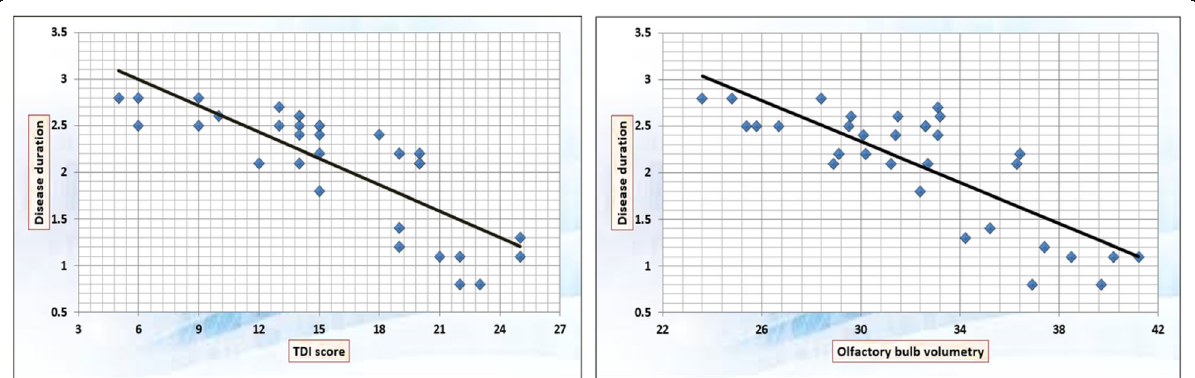
Fig. 3 Negative correlation between Parkinson ’ s disease duration and each of threshold, discrimination, identification global score (left), and the olfactory bulb volumetry